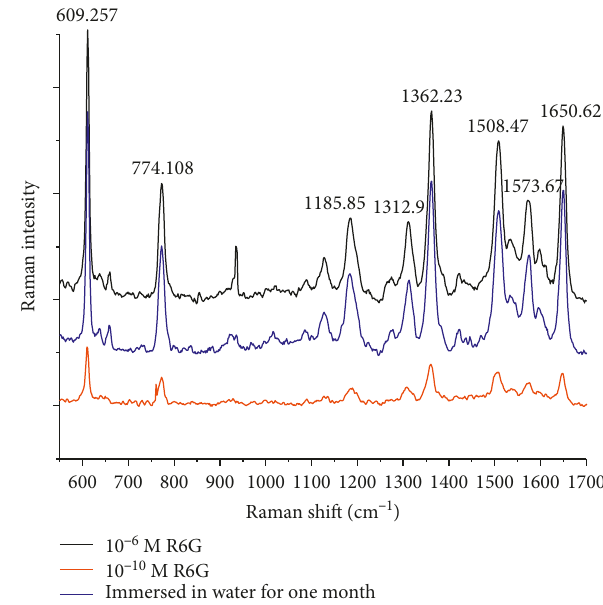
Figure 9: The Raman spectra for the substrates dyed by different concentrations of R6G. And the Raman signal of sample immersed in water for one month which was dyed by 10